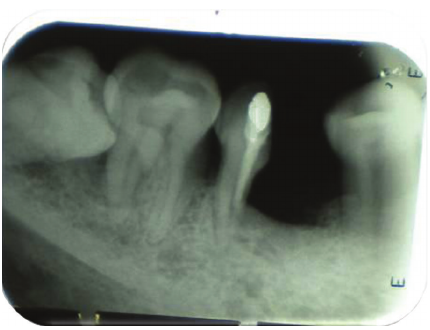
Figure 4: Bone formation after 3